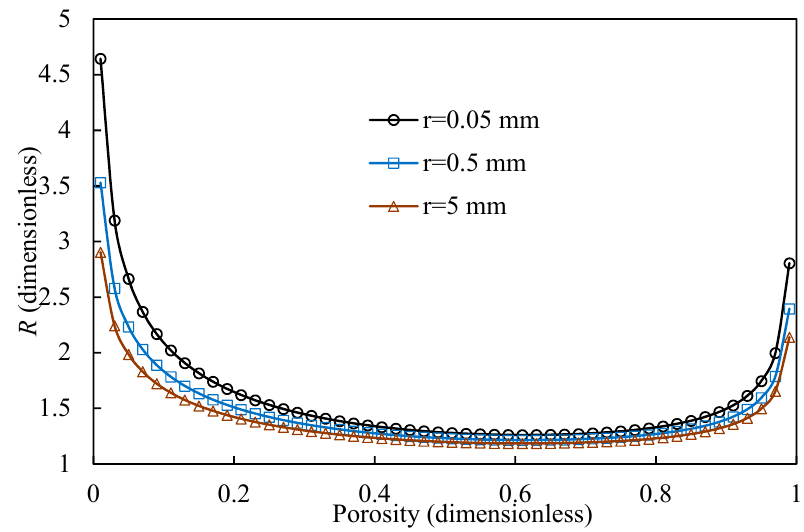
Figure 10. The relationship between porosity and permeability differential coefficient.